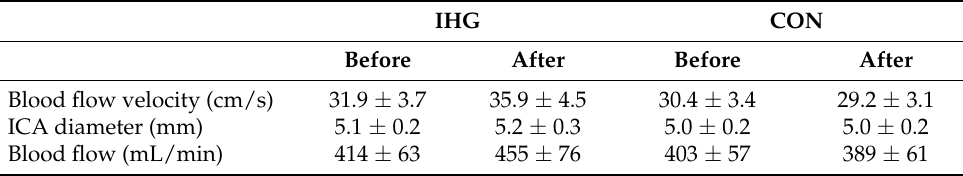
Table 4. Changes in blood flow velocity, ICA diameter, and blood flow. IHG CON Before After Before After Blood flow velocity